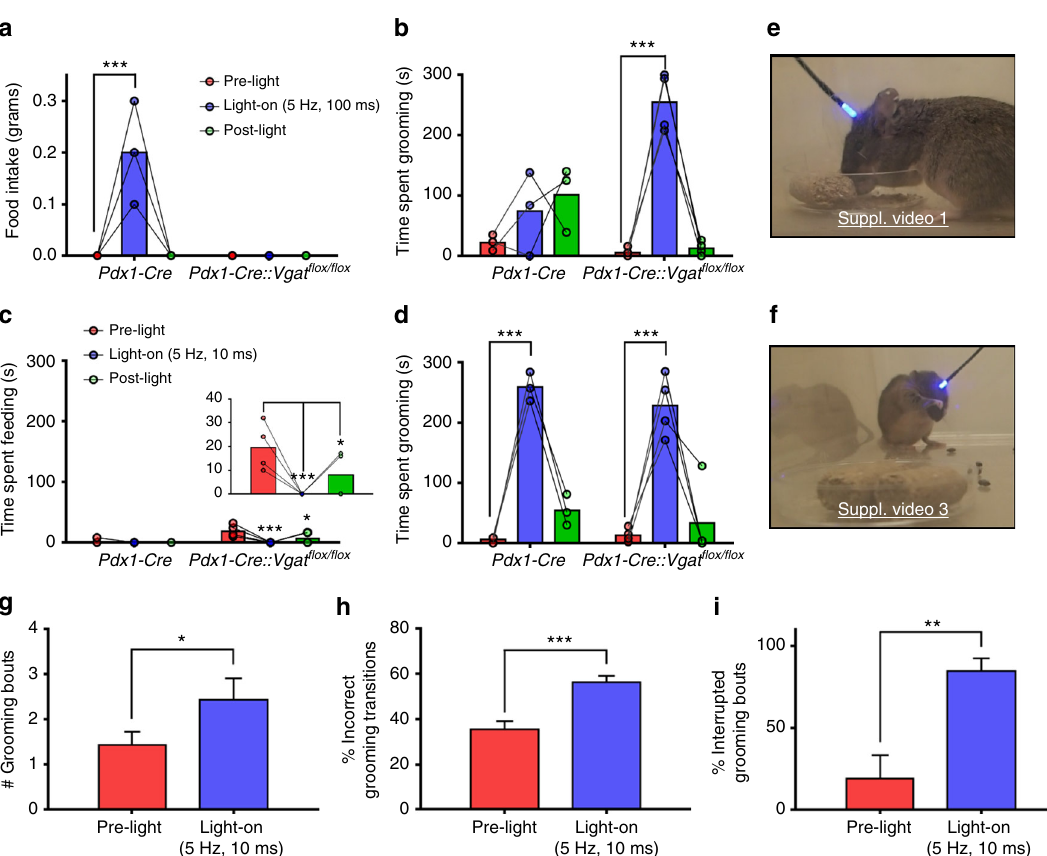
Fig. 2 Optical activation of LH Pdx1 → PVH projections differentially causes feeding and repetitive grooming behaviors, with the former requiring GABA release. Food intake ( a ) and grooming time ( b ) before (pre-light), during (light-on), and after (post-light) 5 Hz, 100 ms photostimulation of LH Pdx1- ChR2 → PVH fi bers in Pdx1-Cre and Pdx1-Cre::Vgat fl ox/ fl ox mice. Feeding time ( c ) and grooming time ( d ) before, during, and after 5 Hz, 10 ms photostimulation of LH Pdx1-ChR2 → PVH fi bers in the same mice. Insert in c is expanded from Pdx1-Cre::Vgat fl ox/ fl ox grooming data in the same fi gure. Snapshots taken from videos of Pdx1-Cre ( e ) and Pdx1-Cre::Vgat fl ox/ fl ox ( f ) engaged in feeding and grooming behaviors, respectively, during light-on epoch (5 Hz, 100 ms) (Supplementary Videos 1 and 3). g – i Grooming microstructure characterization during pre-light and light-on (5 Hz, 10 ms) epochs. a – d and g – i Pre-light, light-on, and post-light epochs occurred consecutively and lasted 5 min each; Pdx1-Cre , n = 3 animals; Pdx1-Cre::Vgat fl ox/ fl ox , n = 4 animals. a – d Two-way repeated measures ANOVA followed by Dunnett ’ s multiple comparisons test. ( a interaction F [2, 10] = 17.14, P = 0.0006; genotype F [1, 5] = 17.14, P = 0.0090; light, F [2, 10] = 17.14, P = 0.0006; subjects [matching] F [5, 10] = 1, P = 0.4651. Pdx1-Cre [pre-light vs. light-on] *** p < 0.0005. b interaction F